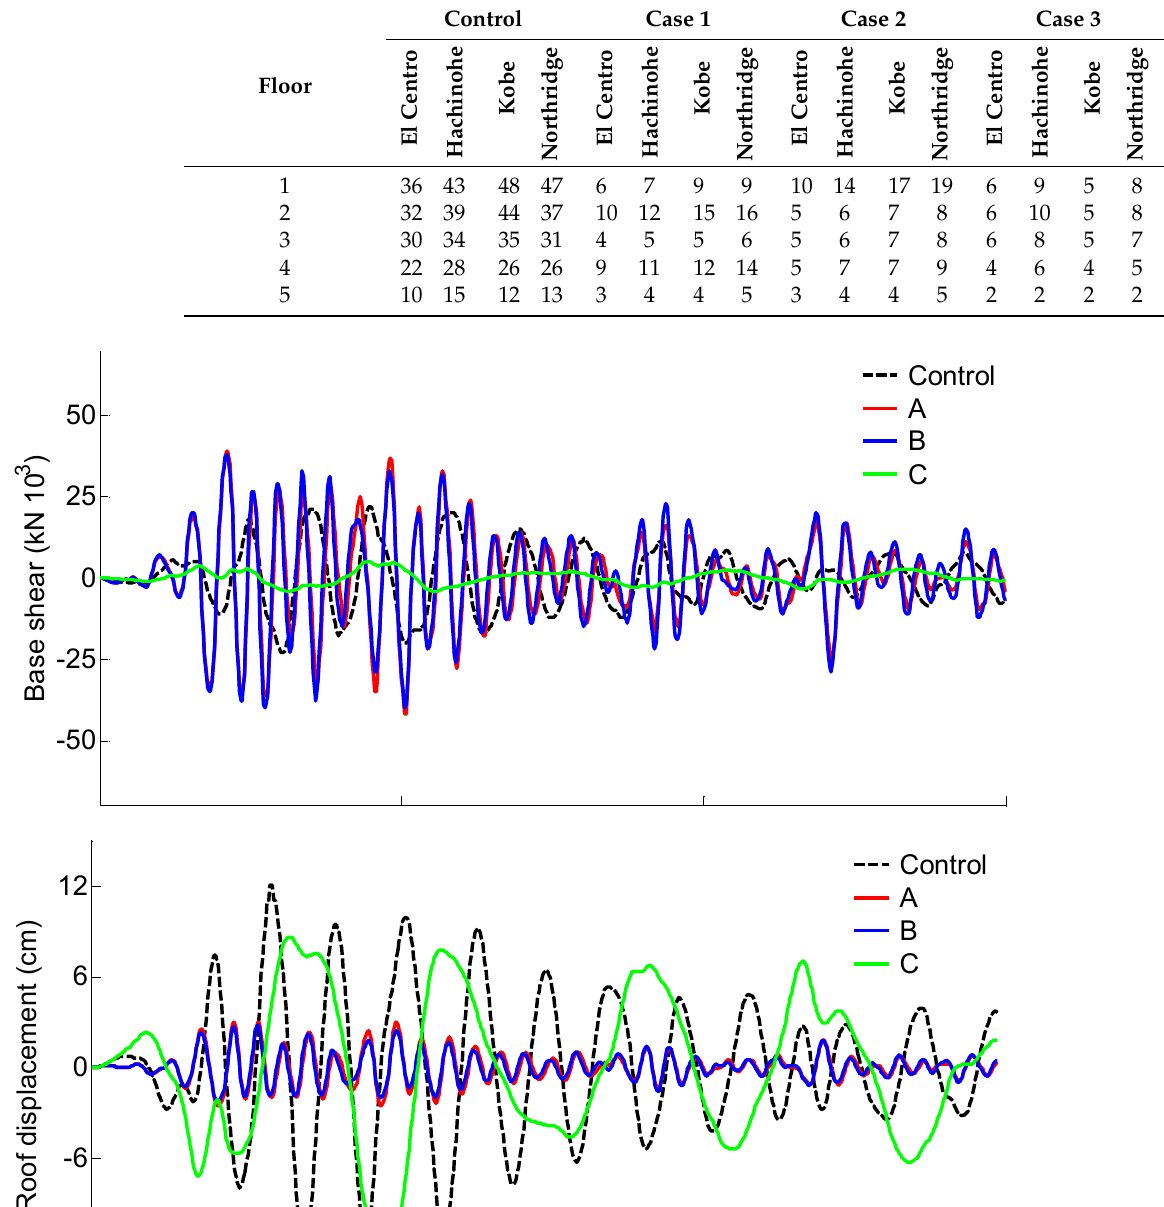
Table 7. Peak inter-story drifts in mm for each of the earthquakes: El Centro, Hachinohe, Kobe, and Northridge.